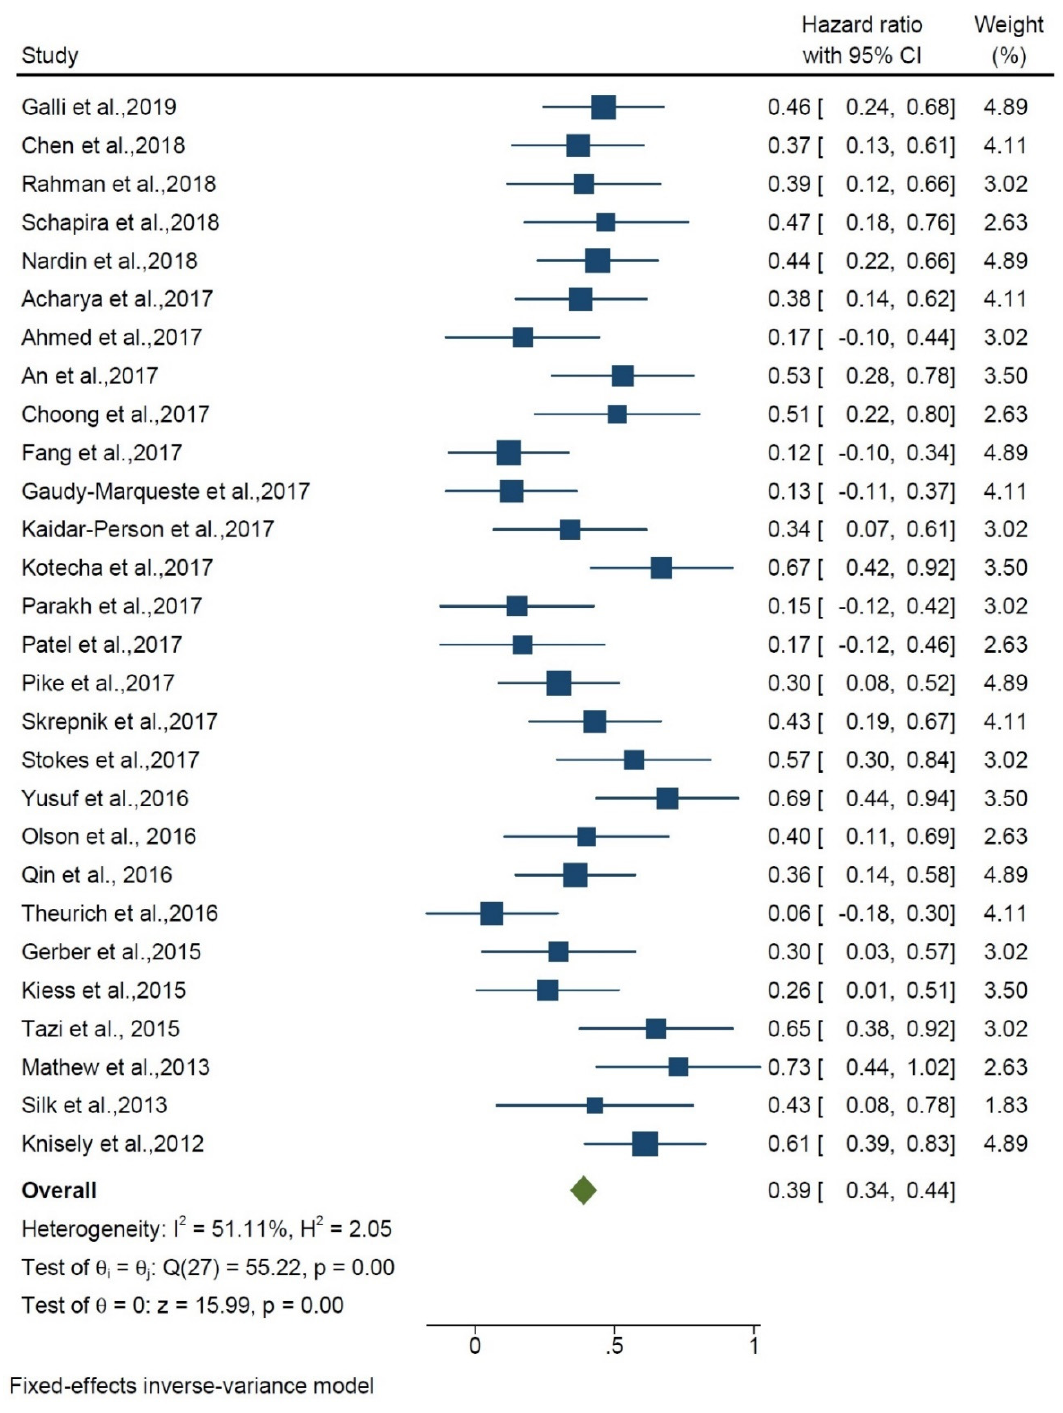
Figure 2. Forest plot shows overall survival of RT + IT vs RT alone.